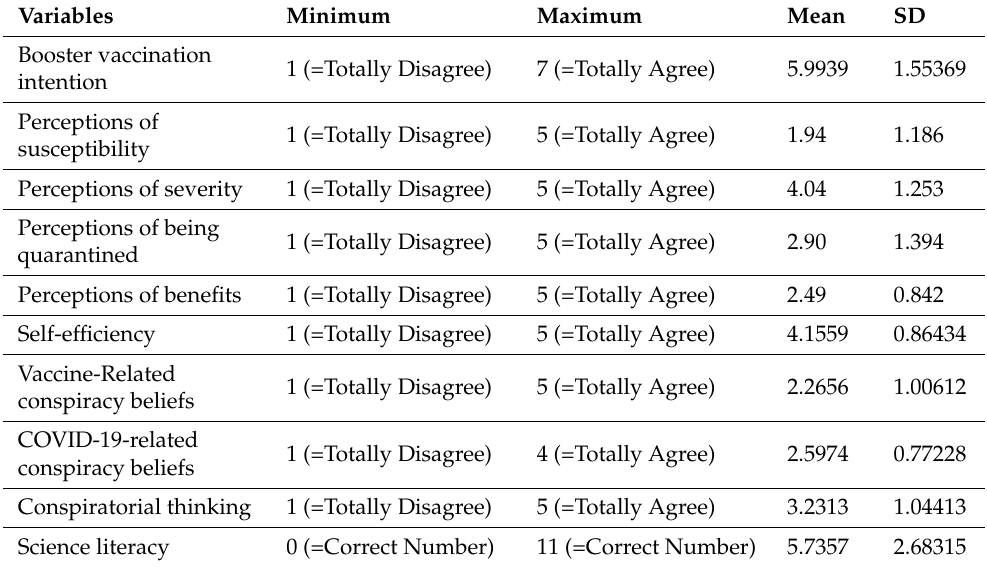
Table 1. Descriptive statistics and units of the continuous